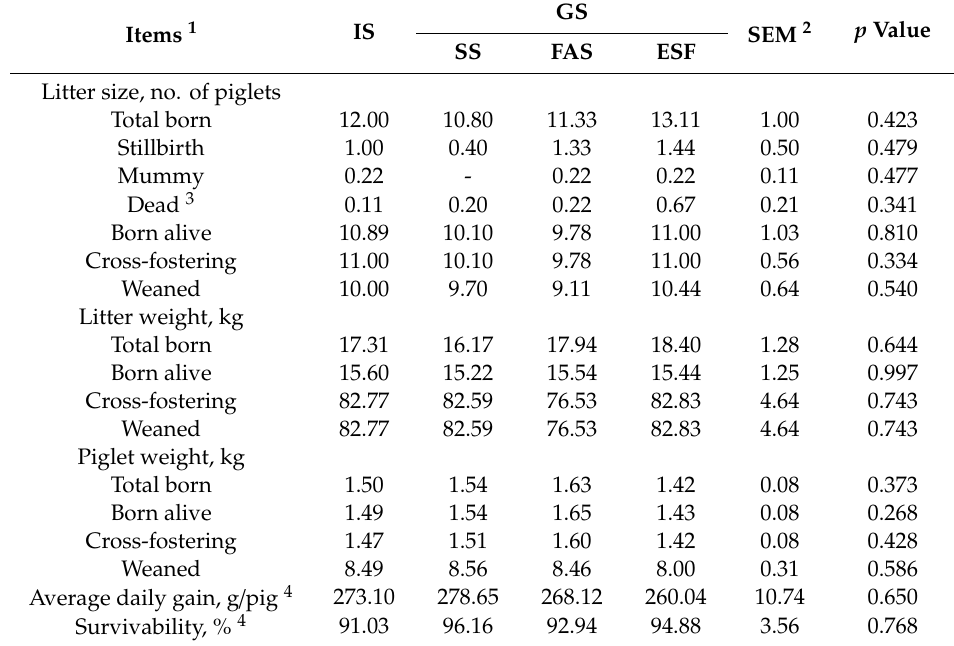
Table 4. Effects of individual stalls (IS) and group housing systems (GS) on sow reproductive performance. Items